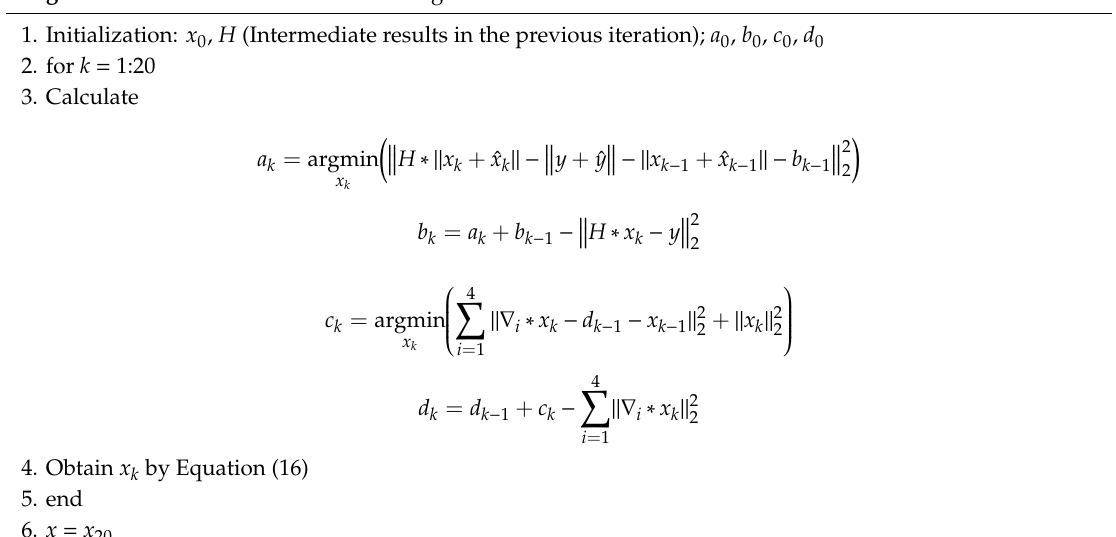
Algorithm 2. The calculation of clear